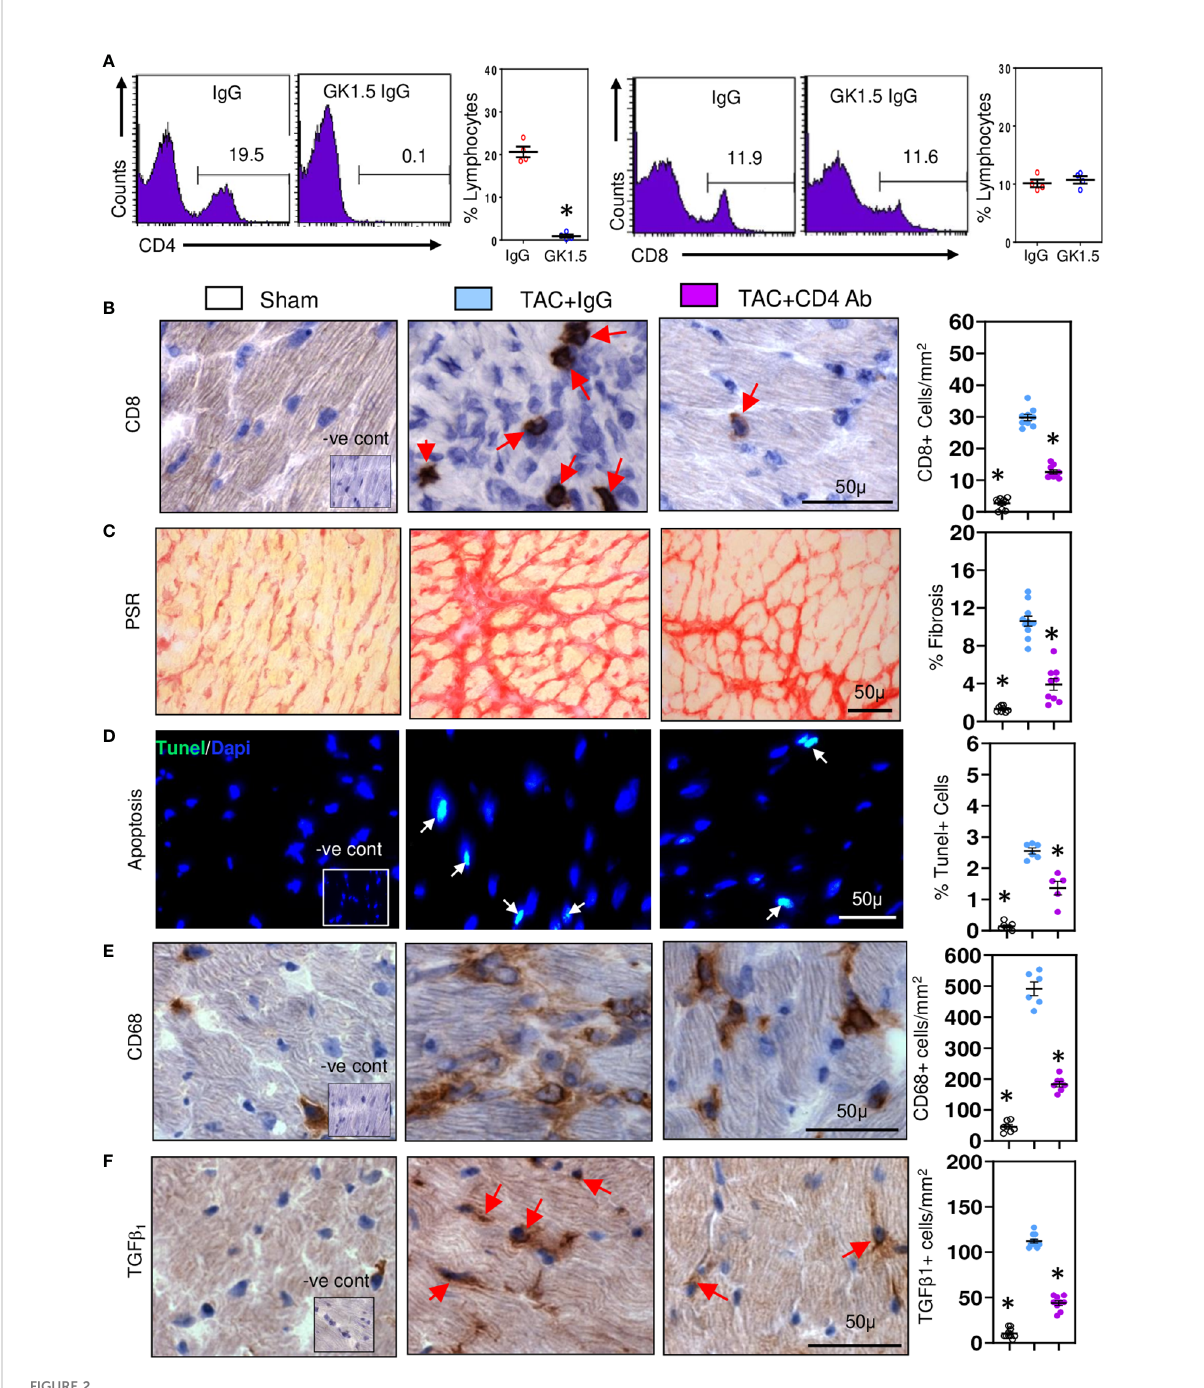
FIGURE 2 CD8+ T cells require help from CD4+ T cell in promoting cardiac fi brosis. (A) Representative FACS plots showing treatment of TAC mice with anti-CD4 antibodies depletes spleen CD4+ cells without affecting CD8+ cells controls. (B) Depletion of CD4+ T cells signi fi cantly reduces ventricular CD8+ T numbers compared to controls during fi brosis in TAC mice. (C) LV fi brosis staining is greatly reduced following CD4+ T cell depletion in TAC mice. (D) TUNEL+ cells are reduced by CD4+ T cell depletion in TAC mice. (E) CD68+ macrophage numbers are reduced with CD4+ T cell depletion. (F) Numbers of TGF- b 1 expressing cells in LV are reduced with anti-CD4 antibody treatment. Results are means ± SEM with small circles representing data from individual mice. n=4-9/group. PSR; picrosirius red, -ve control; no primary antibody control, scale bar represents 50µm. *P< 0.05 using two-tailed Student ’ s t-test one-way ANOVA comparing to